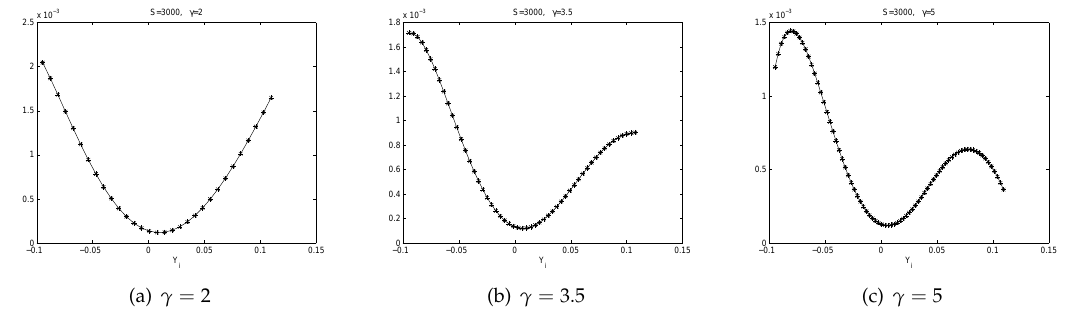
Figure 11. ˆ f , S = 3000.